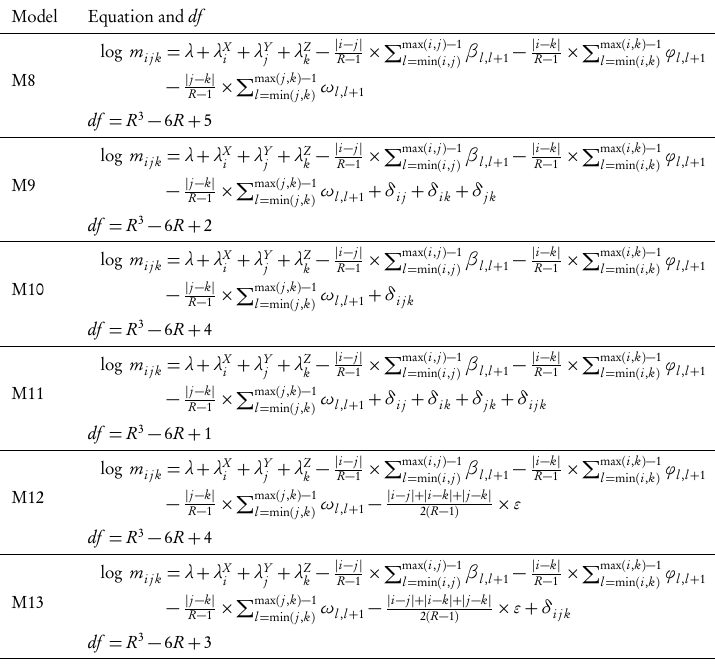
The non-uniform association and non-uniform association plus agreement models for